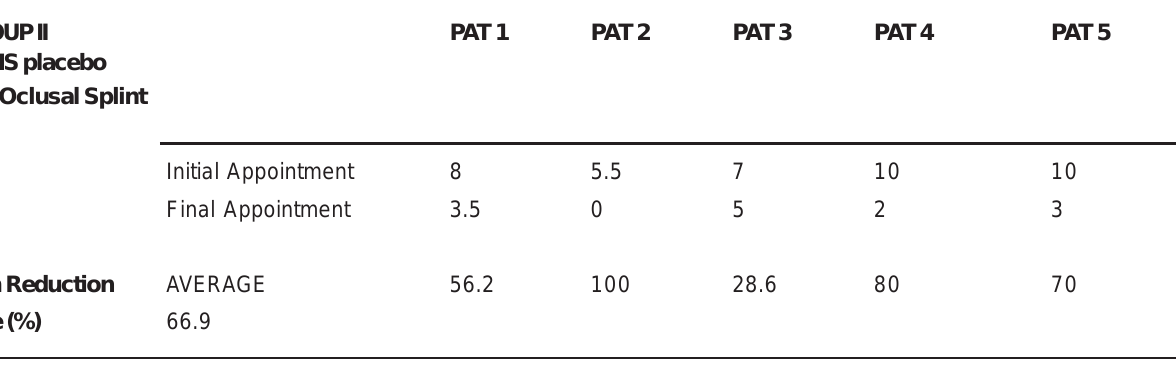
TABLE 2- Pain level of patients before and after treatment in group II (MENS placebo and Occlusal Splint) using a Visual Analogue Scale